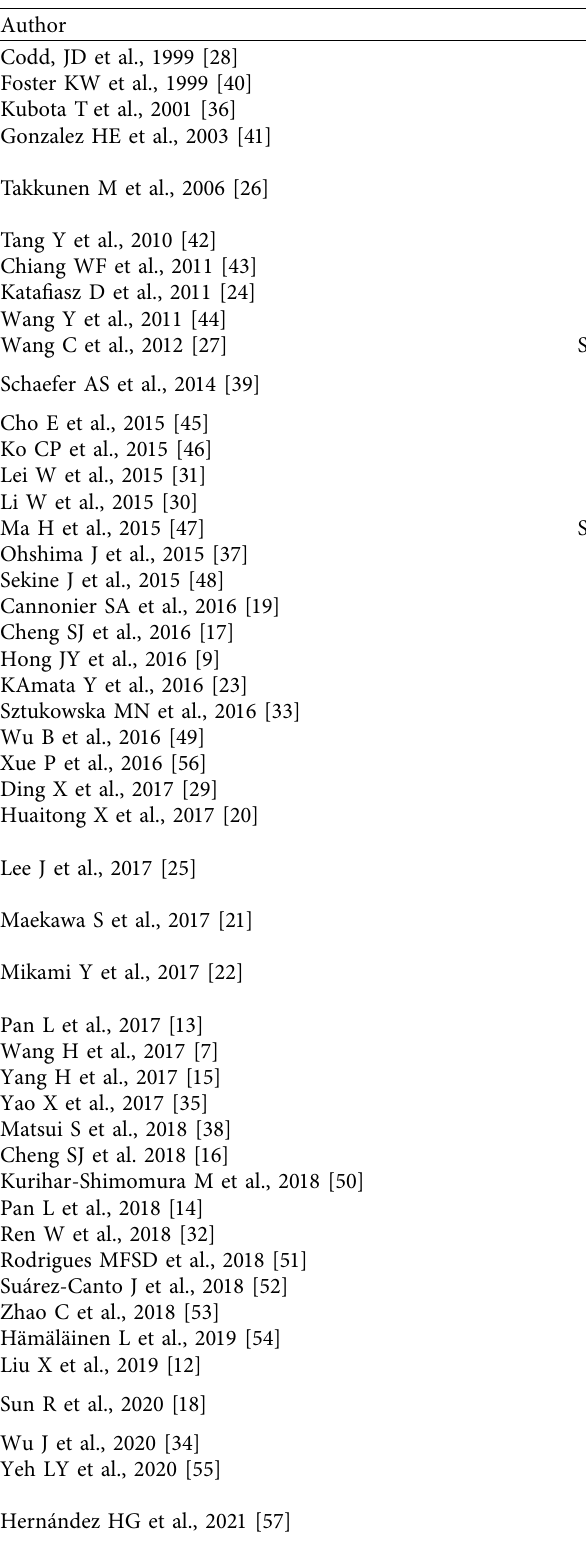
Table 1: Studies evaluating the role of zinc finger proteins in various oral